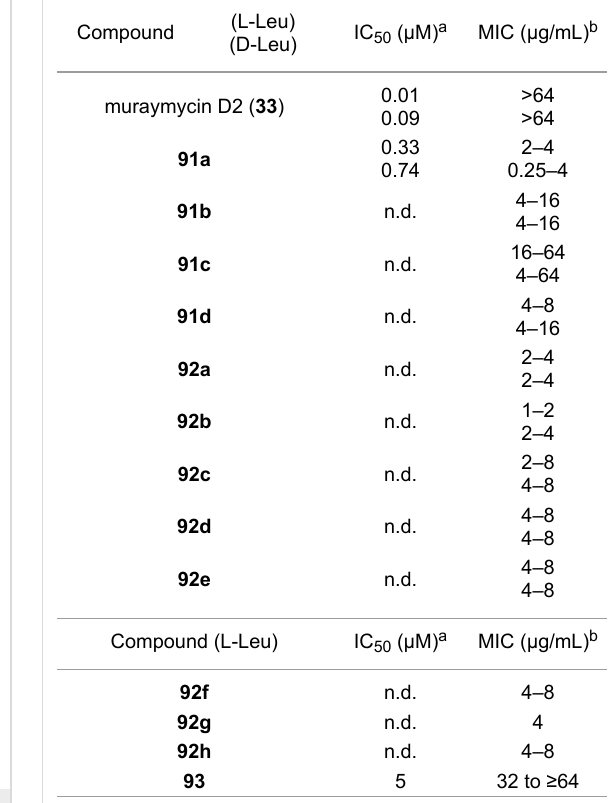
Table 2: Inhibitory (against MraY) and antibacterial activities of non- natural lipophilic muraymycin analogues